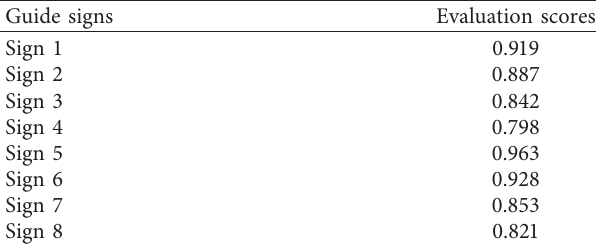
Table 12: Comprehensive evaluation